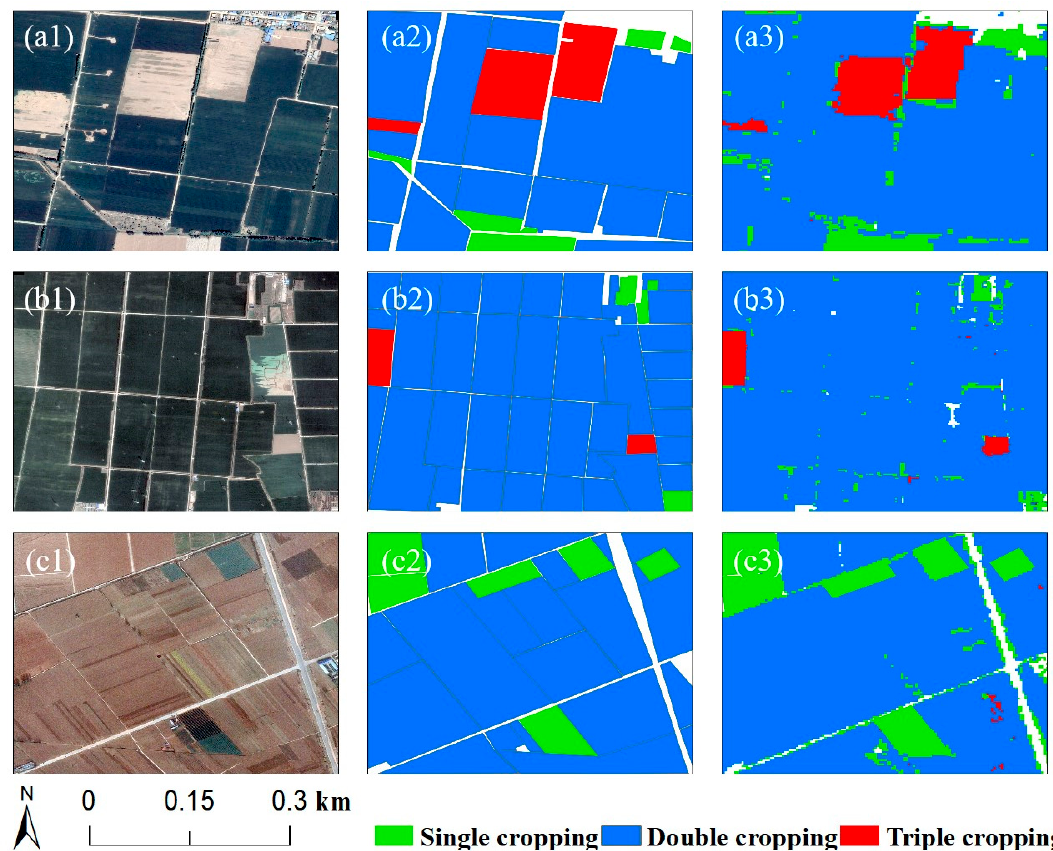
Figure 7. Accuracy evaluation of the results of cropping intensity classification based on the composite image of the study area. ( a1 – c1 ) are Google Earth images; ( a2 – c2 ) are ground reference data generated by visual interpretation combined with survey data; ( a3 – c3 ) are results in this study. Image source: Image 2021 CNES/Airbus. Color composite: RGB (red, green, blue).